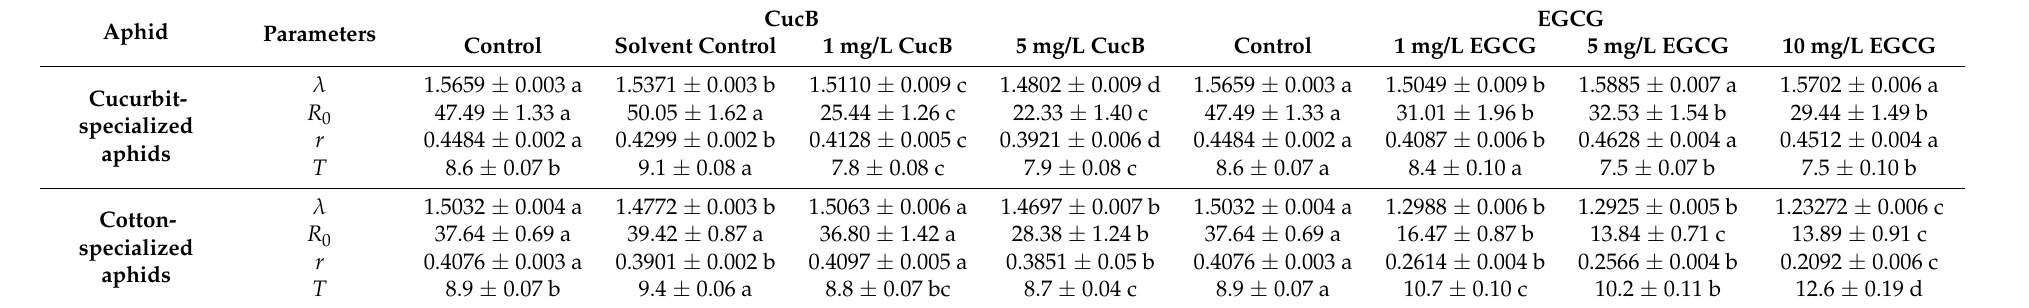
Table 2. Effects of CucB and EGCG on population parameters of Aphis